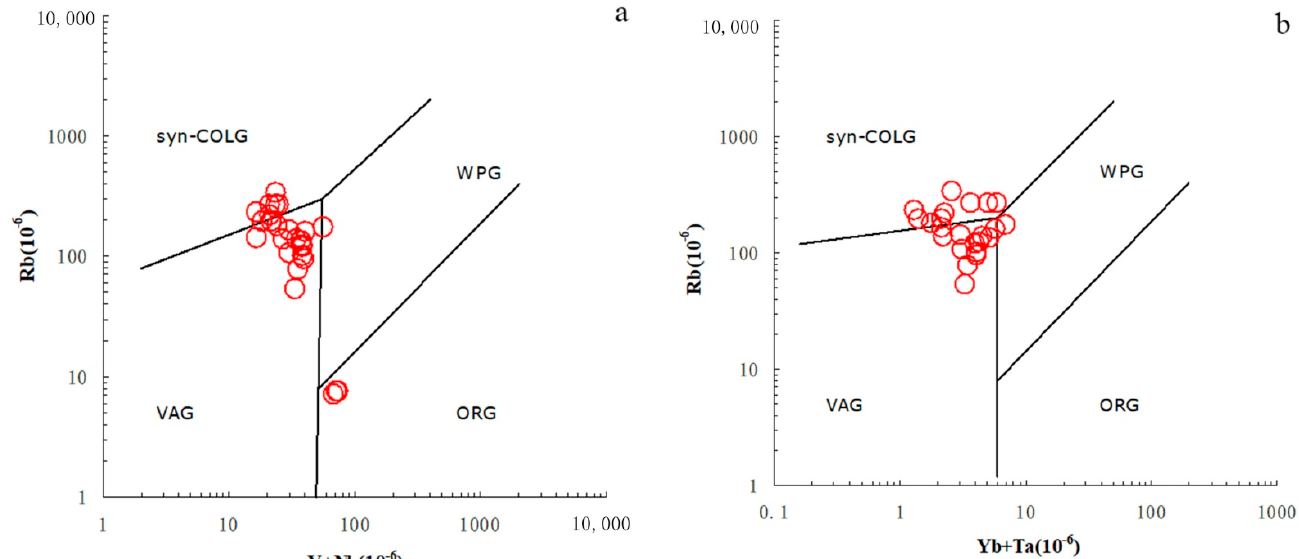
Figure 10. ( a ) Y + Nb vs. Rb and ( b ) Yb + Ta vs. Rb diagrams for the Dahongliutan pluton (according to Pearce, et al. [17]) (WPG: within-plate granite; VAG: volcanic arc granite; syn-COLG: syn-collisional granite, ORG: ocean ridge granite).